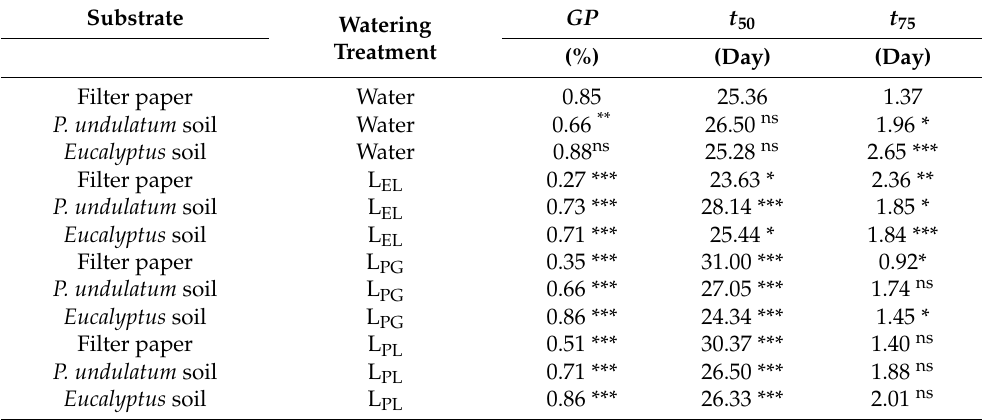
Table 2. Germination of Pittosporum undulatum seeds under different substrates (i.e., Filter paper; P. undulatum soil; Eucalyptus soil) and different watering treatments (i.e., Water; L EL = Leachate of Eucalyptus spp. Litter; L PG = Leachate of P. undulatum Green leaves; L PL = Leachate of P. undulatum Litter). In the GP , t 50 and t 75 columns are reported the values obtained with the Nonlinear Mixed- Effects Model ‘( GP + t 50 + t 75 ~ substrate × treatment)’ with the function SSLogis() and in superscript are noted the significance levels obtained by nlme() (ns > 0.05, * 0.01 < p < 0.05, ** 0.001< p < 0.01, *** p < 0.001) and the intercept is Filter paper Water (the relative summary are reported in Table